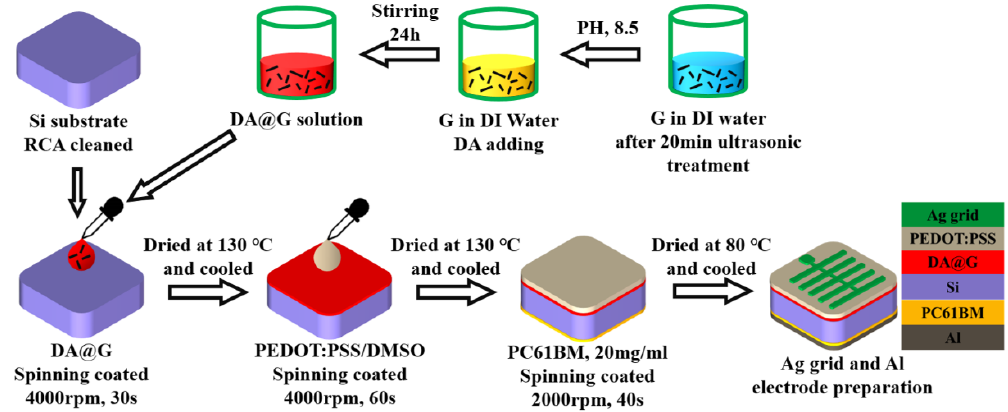
Figure 1. Preparation process for dopamine@graphene (DA@G) solution and solar cell.